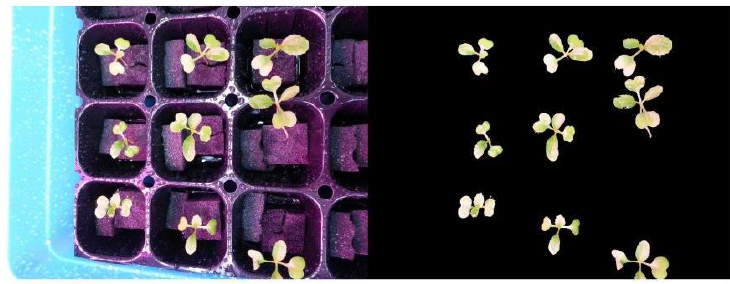
Figure 18. Image of extracted lettuce using image processing.